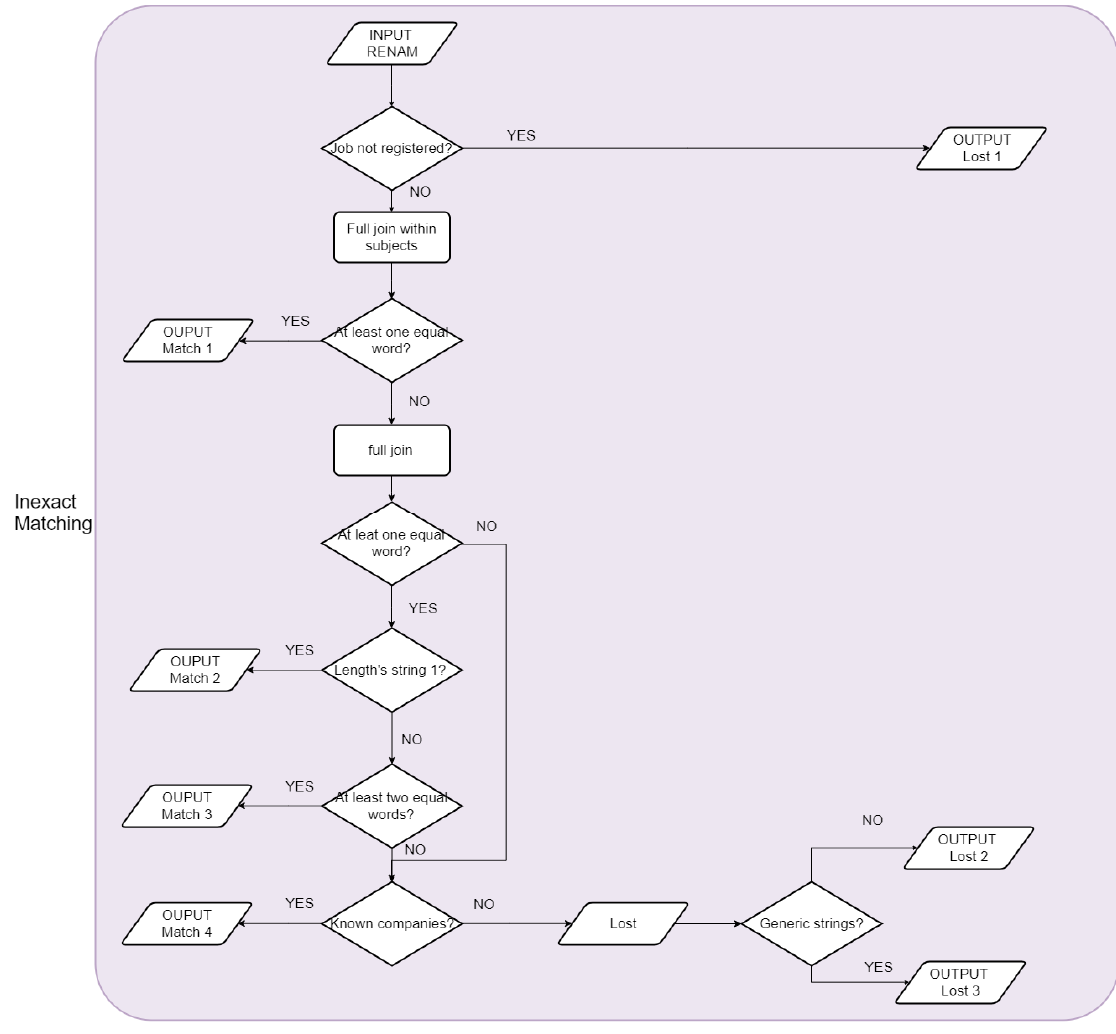
Figure 3. Record linkage flowchart: ‘inexact matching’ steps.